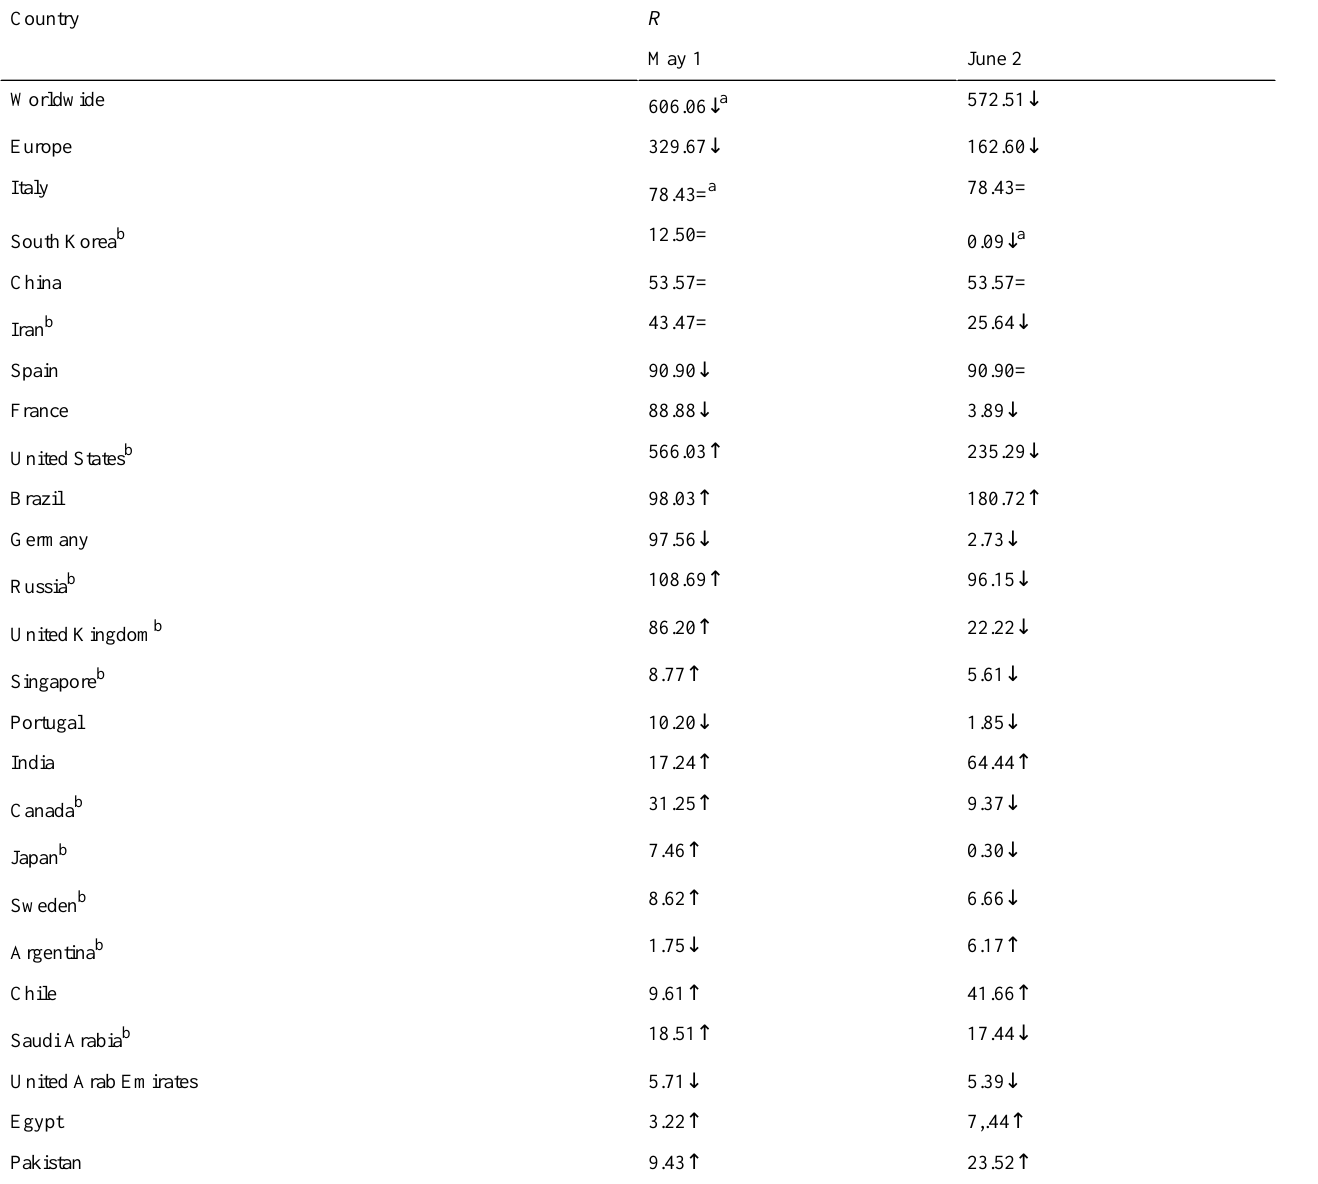
Table 4. COVID-19 maximum exponential growth patterns per population and time period by country or region from May 1 to June 2, 2020. Data source: Worldometer